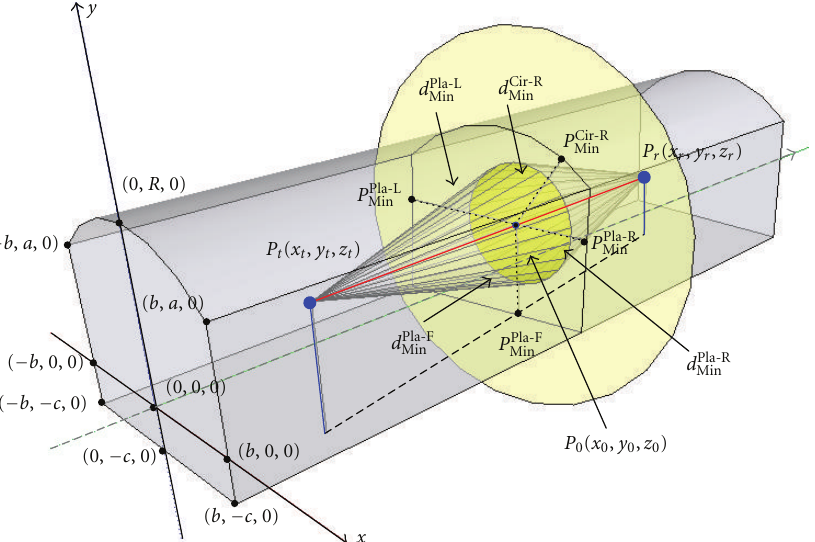
Figure 5: Detailed schematic diagram of the propagation inside the arched tunnel “Type I” with the first Fresnel zone clearance.